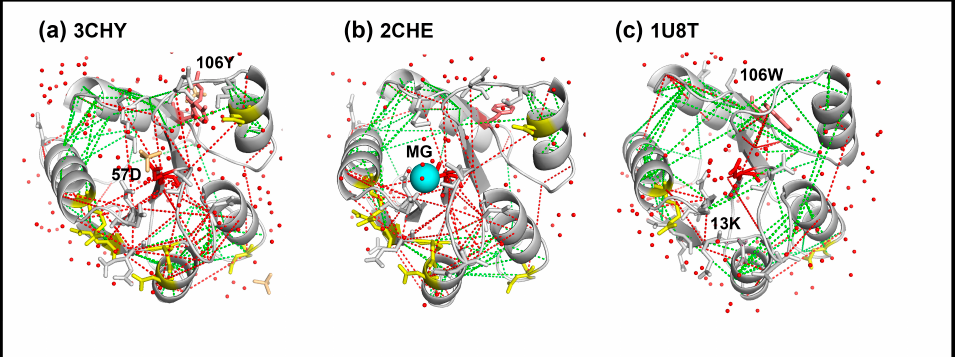
Figure 3. Activation-dependent change in fold energetics. The Frustratometer2 algorithm computes residue contact energies relative to a decoy contact distribution with a coarse-grained AWSEM force-field. The PDB structures with superimposed high (red lines) and low (green lines) contact energies relative to the decoy distributions are shown. ( a ) Apo-CheY. High-energy contacts radiate out from 57D (red sidechain) to surrounding residues that include residue positions detected by XFMS (stick sidechains) with anomalous low (yellow) or comparable (white) Log (PF) values to non-polar residues (see text). 106Y sidechain (salmon). ( b ) Mg 2+ bound apo-CheY. Magnesium ion (cyan sphere). ( c ) 13DK,106YW CheY. Activated by bound FliM N (not shown). XFMS residue positions in ( b , c ) as in ( a ). There is a reduction in the high energy contacts of 13D/K, 106YW CheY 57D with surrounding residue positions relative to the apo-CheY forms. Waters (red dots).